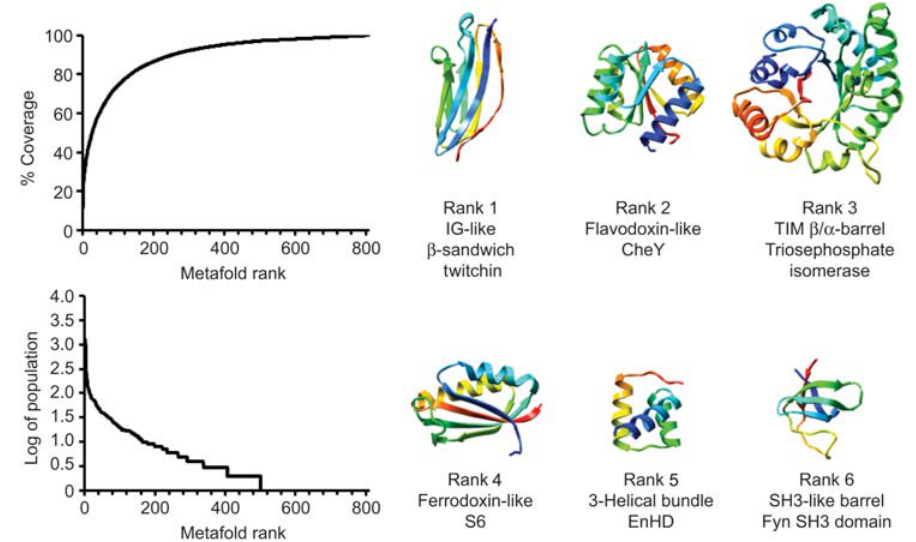
Figure 2 Dynameomics fold space. (Top left) Cumulative percentage of all 13 345 non-redundant domains in the metafolds. (Bottom left) Log of the non-redundant population of each metafold. (Right) Metafold representatives of the top six metafolds. Structures are shown in ribbons colored in rainbow from red to blue. Metafold rank and name, along with the protein name are listed below each